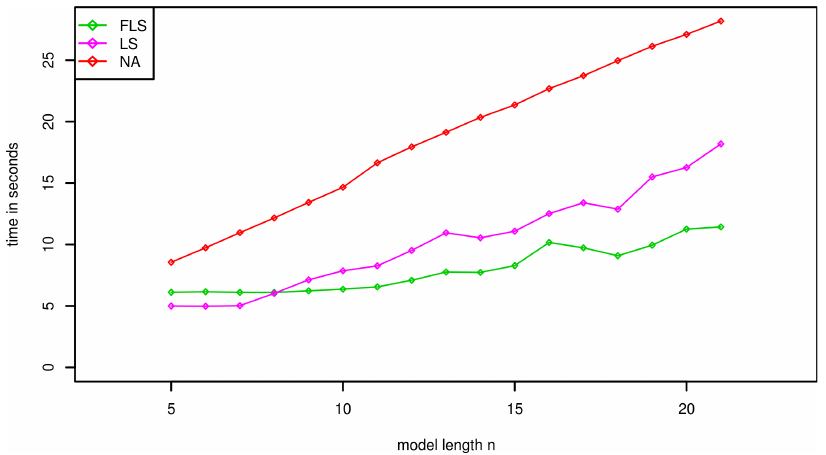
Fig 4. Average running times (in Seconds, Preprocessing excluded) of different algorithms for real-world model MOD3 and sequence SEQ2 with p-value γ = 0.0001.